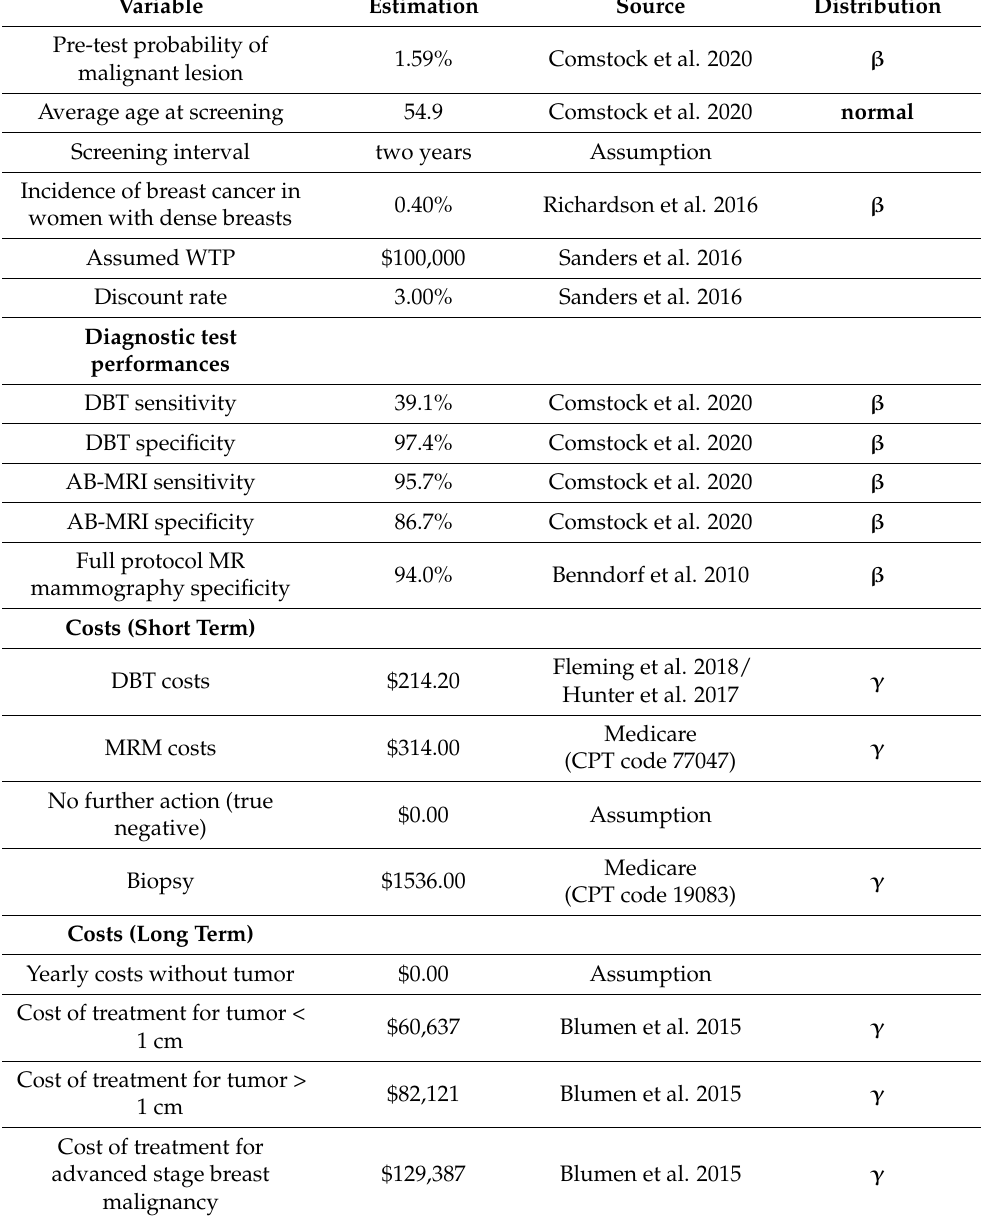
Table 2. Model input